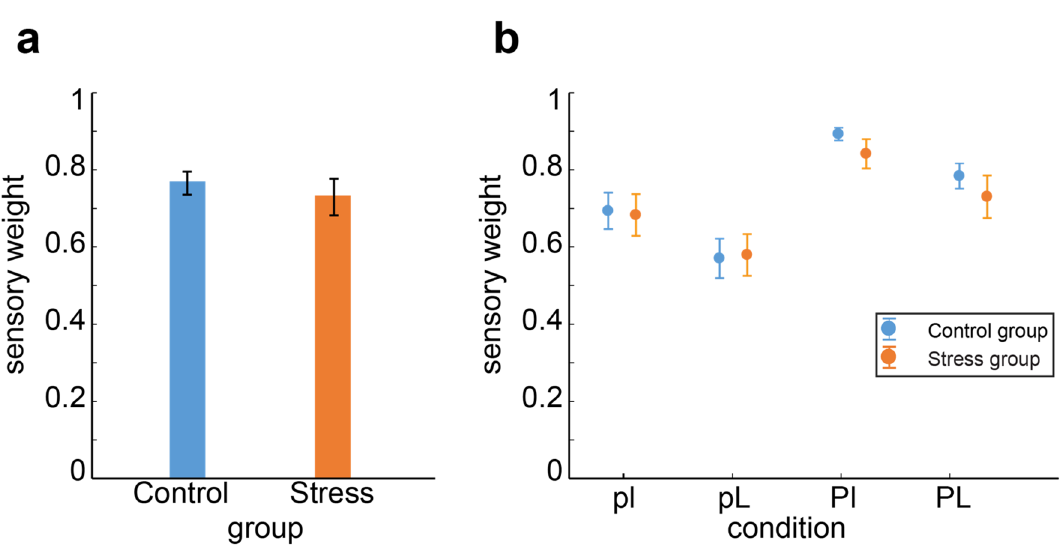
Figure 3. Behavioral results. ( a ) Average general sensory weight for participants in the stressed group (in orange) and the control group (in blue). The sensory weight quantifies the degree to which subjects rely on the current visual sensory information (likelihood) vs. the prior (see “Methods” for details). ( b ) Average sensory weights, separated by condition. Error bars in ( a ) and ( b ) represent the standard error of the mean. Conditions: pl: small prior and sensory/likelihood uncertainty; pL: small prior uncertainty, large sensory uncertainty; Pl: large prior uncertainty, small sensory uncertainty; PL: large prior and sensory